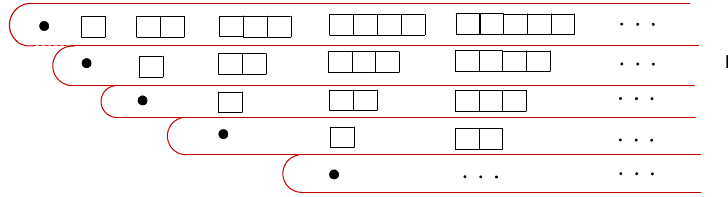
Figure 1 . The so (1 ; 1)-covariant basis of hs [ (cid:21) ] in the twisted form. Each Young diagram of length k is an so (1 ; 1) rank- k irreducible module d k . Subspaces